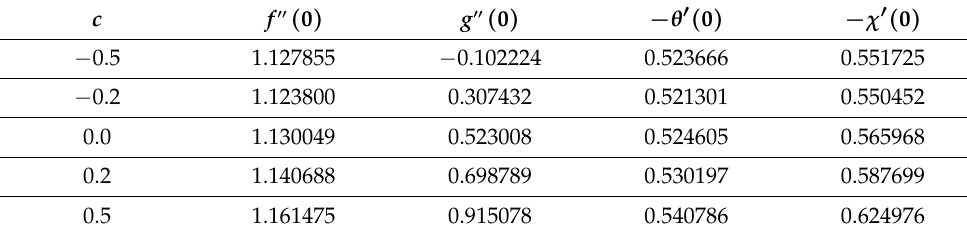
Table 3. Computational values of f (cid:48)(cid:48) ( 0 ) , g (cid:48)(cid:48) ( 0 ) , − θ (cid:48) ( 0 ) and − χ (cid:48) ( 0 ) for different values of c .